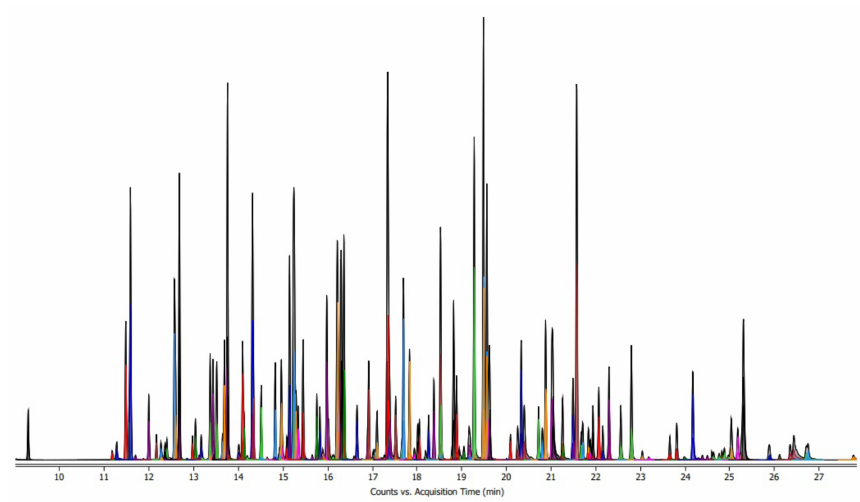
Figure 2. LC-MS/MSstandardsolutionchromatogram. LC:liquidchromatography;